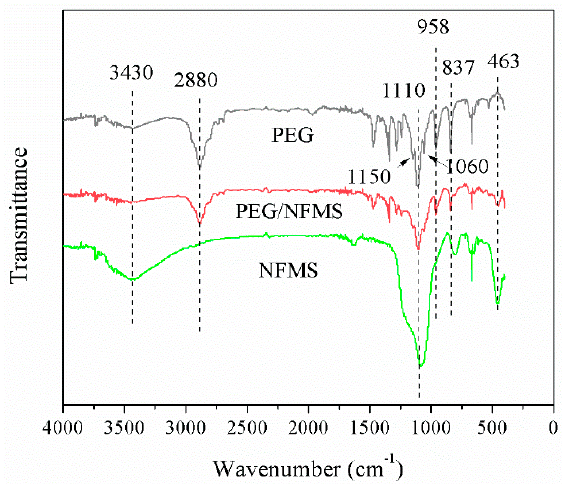
Figure 4. Fourier transform infrared (FT-IR) spectra of pure PEG, NFMS, and 80% PEG/NFMS.